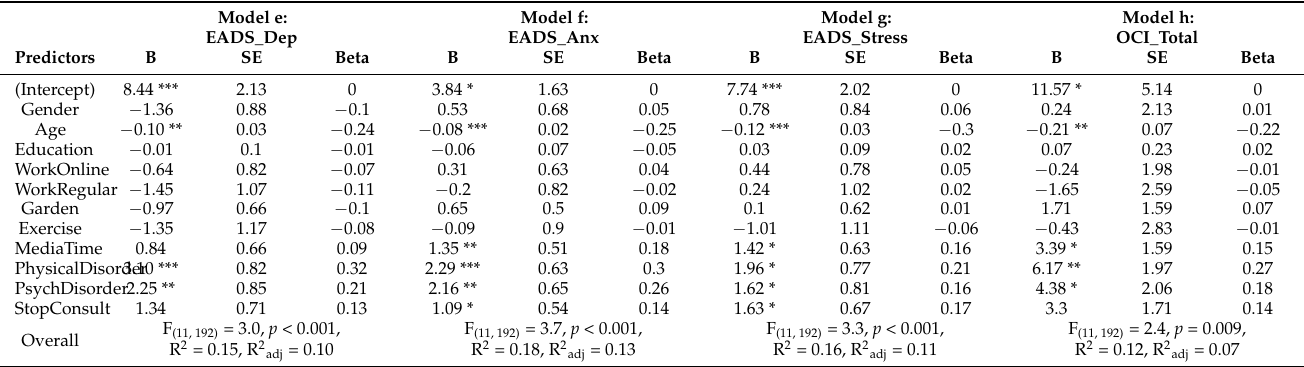
Table 4. Description of the regression models for the sample receiving